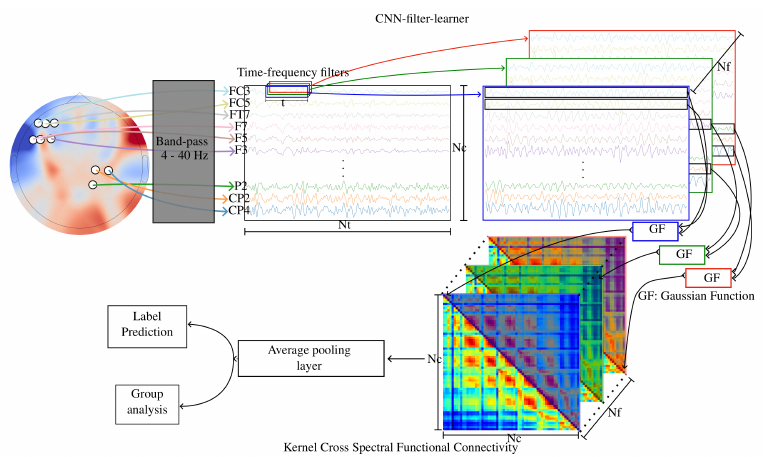
Figure 3. Kernel Cross-Spectral Functional Connectivity Network-(KCS-FCnet) for Motor Imagery Classification main